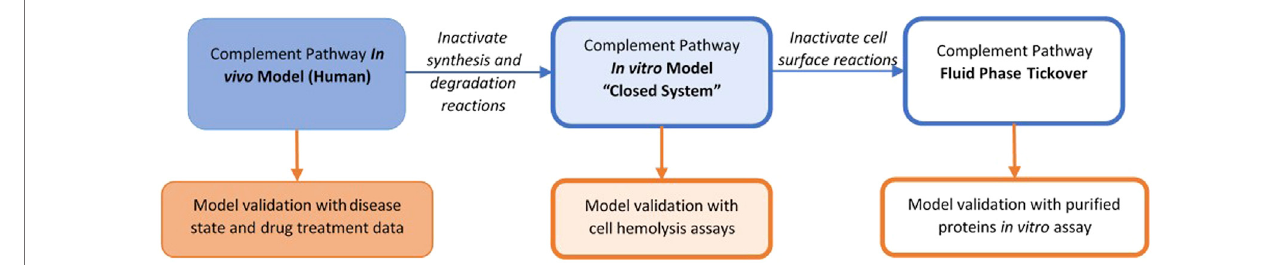
FIGURE 3 | Representations of the complement model for validation with different datasets.